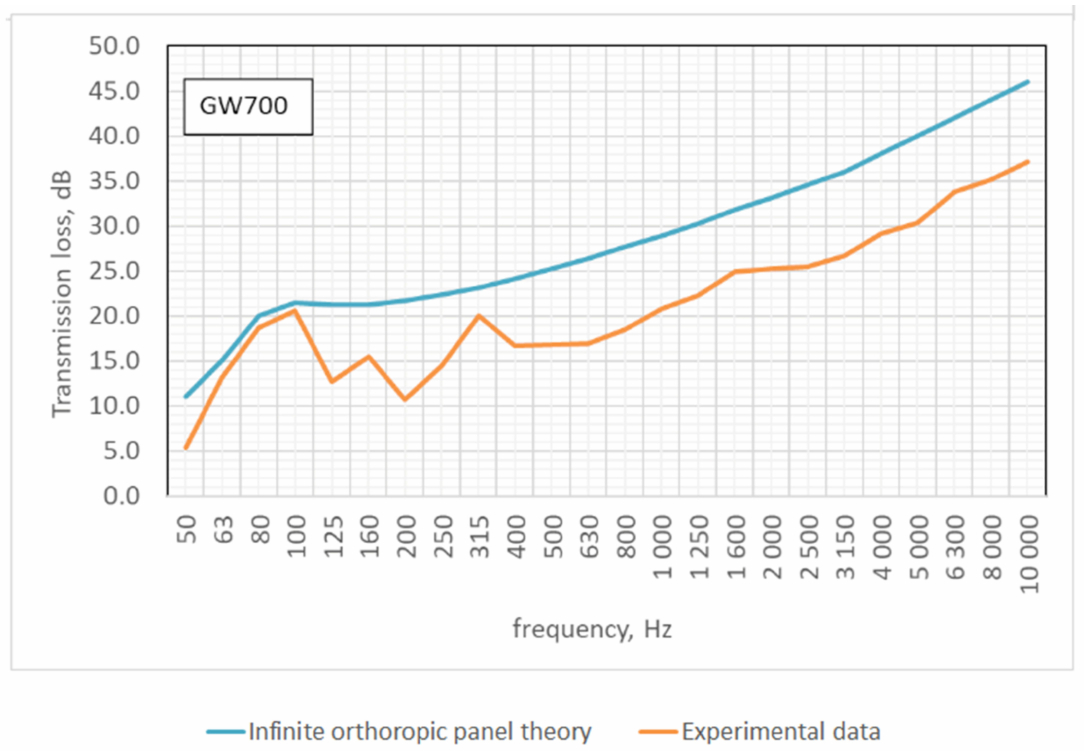
Figure 7. Measured (experimental) and predicted (theory) transmission loss (TL) for GW580 and GW700 PVC panels.